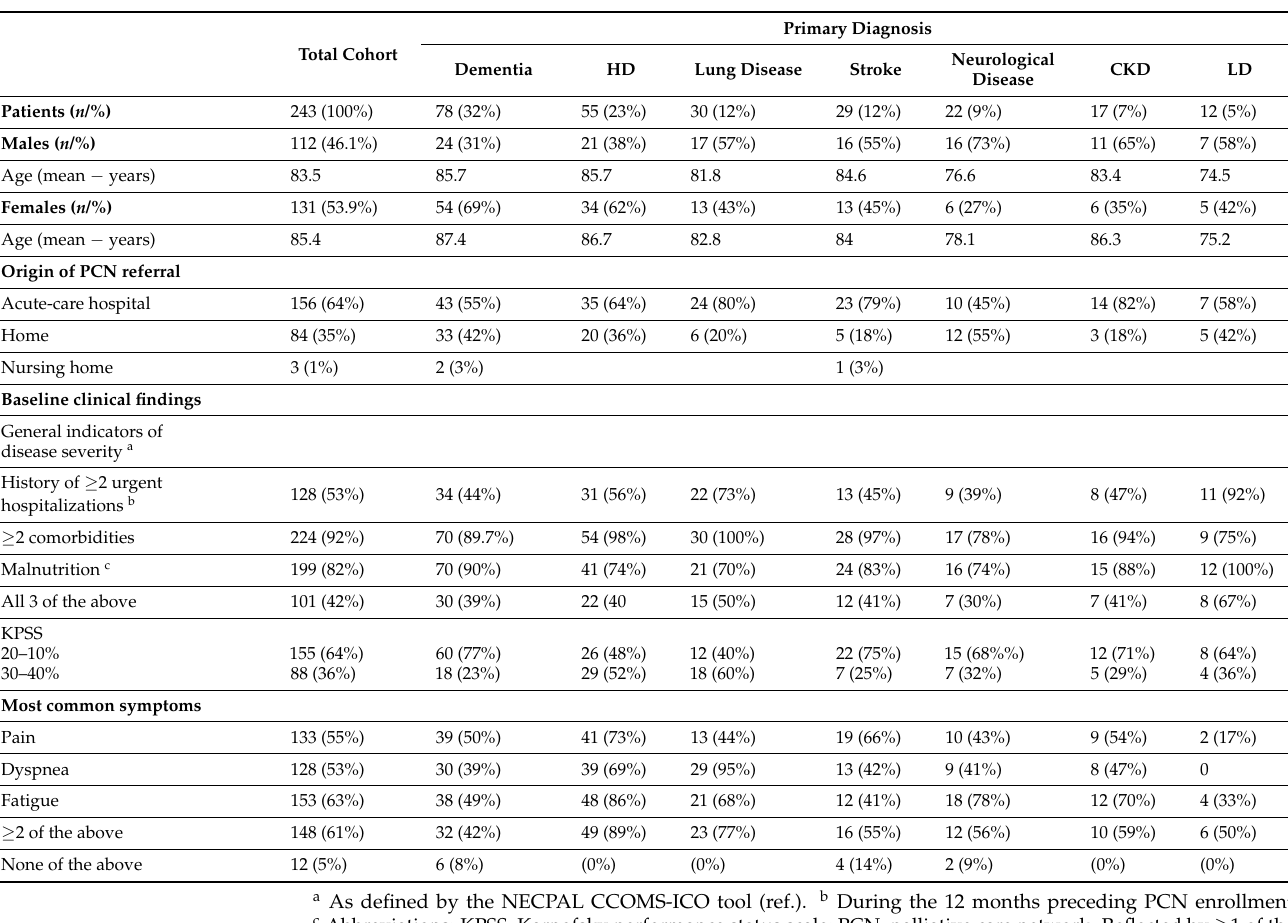
Table 1. Clinical characteristics of the patient cohort at PCN